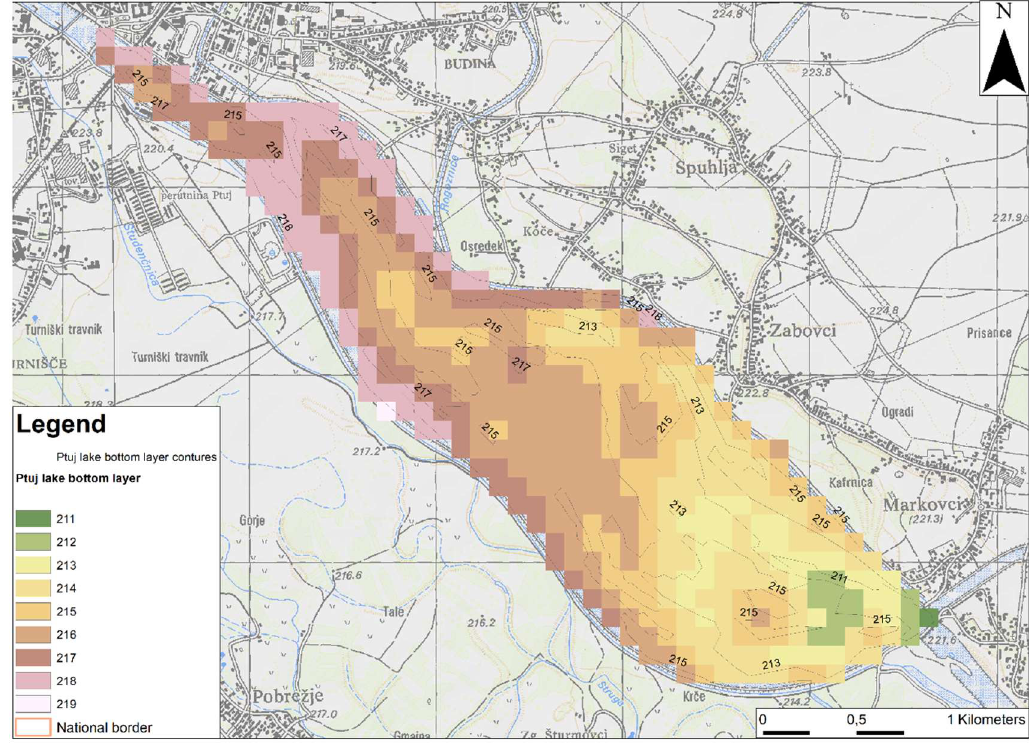
Figure 6. Bottom layer of Lake Ptuj (adapted after Veršič,